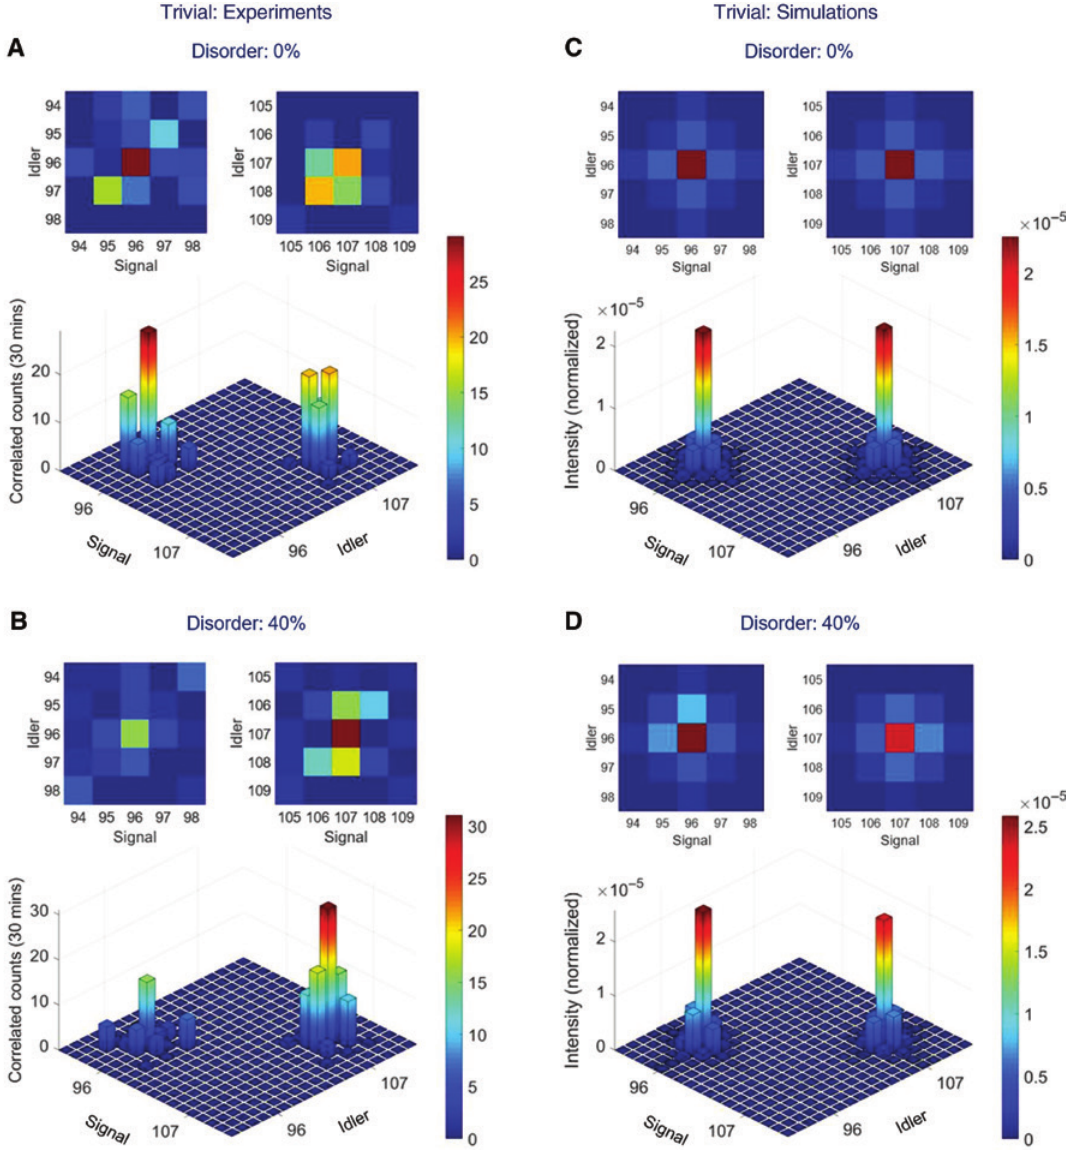
Figure 3: Biphoton states of two trivial lattices. (A,B) Measured biphoton correlations for trivial lattices with random gap disorder. No features in the correlated counts are preserved. (C, D) Corresponding simulations with the gap disorder included. Note that some elements of the biphoton maps between the two defects which were not measured have been omitted for